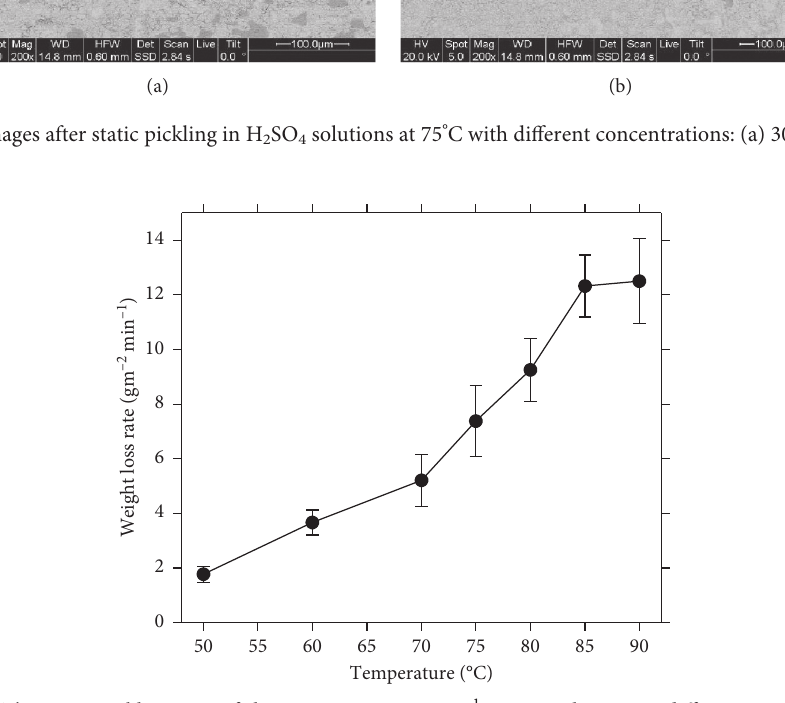
2 SO 4 solutions at different temperatures.